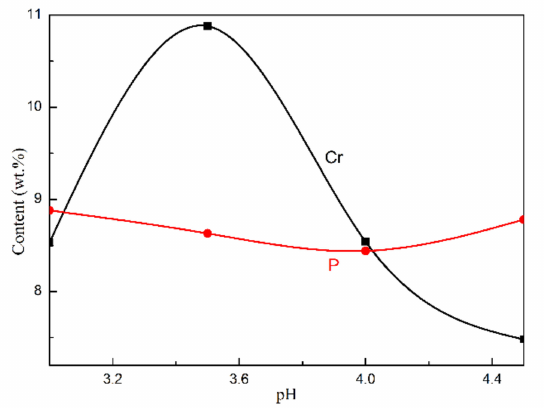
Figure 2. Relationship between the pH and composition of the alloy